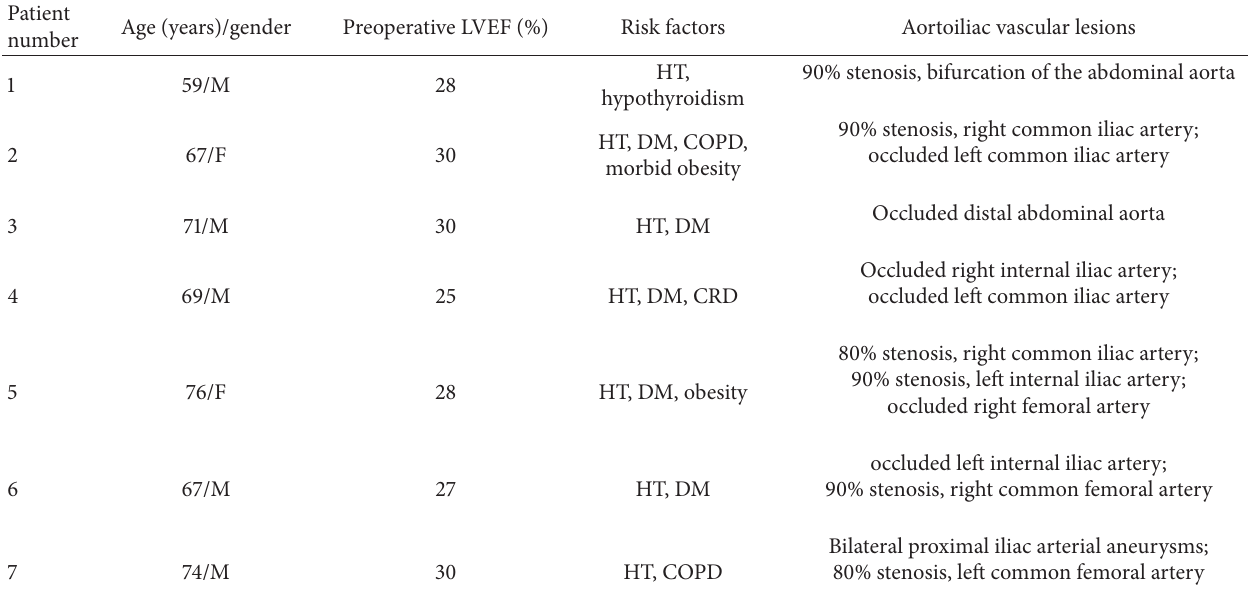
Table 1: The preoperative clinical details of the